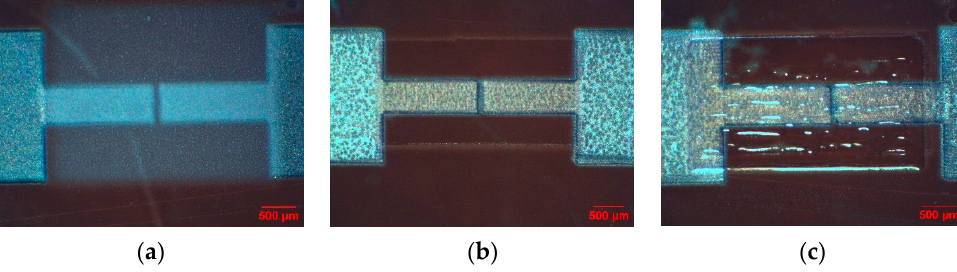
Figure 4. Microscope image of printed CNT source and drain, channel, and dielectric layer on Kap- ton with various concentrations of 2:1 cross-linked PVP ink and carrier gas pressure: ( a ) 2.5 wt.% solution with UA of 18 sccm; ( b ) 2.5 wt.% solution with UA of 22 sccm; ( c ) 5 wt.% solution with UA of 28 sccm.